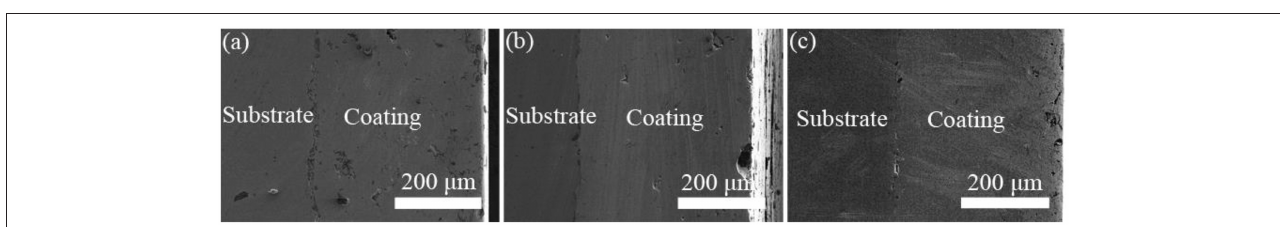
FIGURE 3 | SEM morphologies of polished cross section of NiCrAlY coating: (a) as-sprayed, (b) 900 ◦ C heat treatment, and (c) 1,100 ◦ C heat